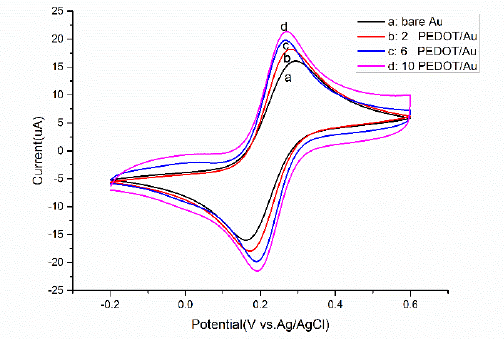
Figure 4. The cyclic voltammograms of different polymerization cycles prepared PEDOT/Au microelectrode in 5 mM [Fe(CN) 6 ] 4−/3− ; scan rate: 100 mV/s.